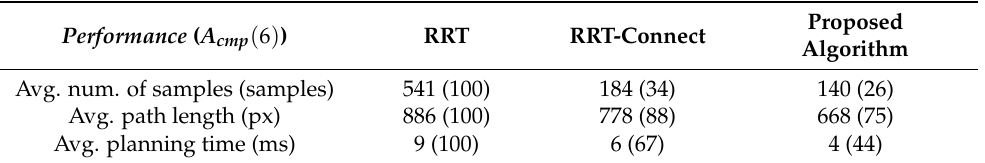
Table 7. Experimental result of Map 6 (the parentheses to the right of each value are the relative ratios based on RRT 100% ( x cmp ( 6 ) )).